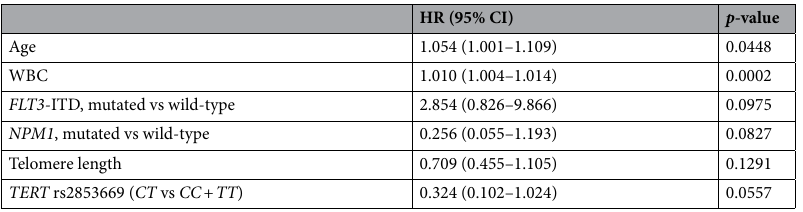
Table 2. Multivariate analysis of factors potentially affecting overall survival in patients with AML. HR Hazard ratio, CI confidence interval, WBC white blood cells count, FLT3-ITD internal tandem duplication of the FLT3 gene, NPM1 nucleophosmin member 1